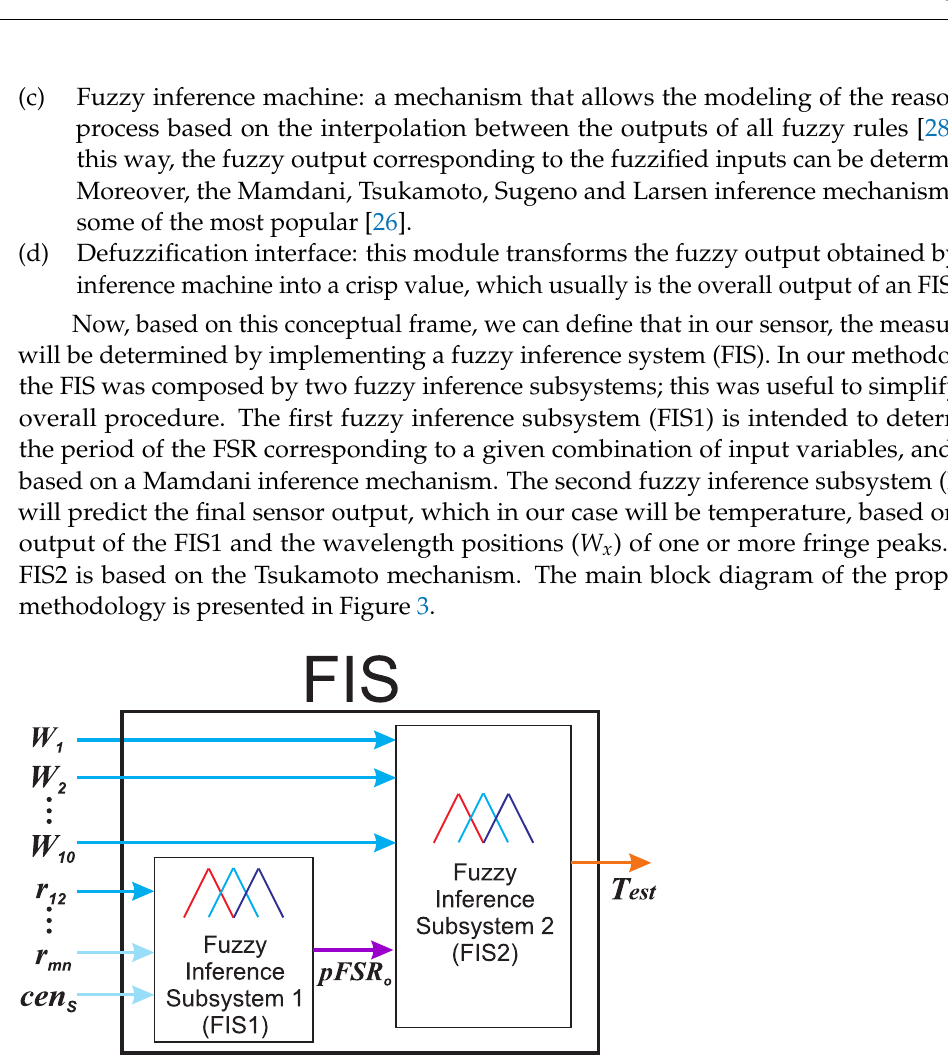
Figure 3. Block diagram of the proposed